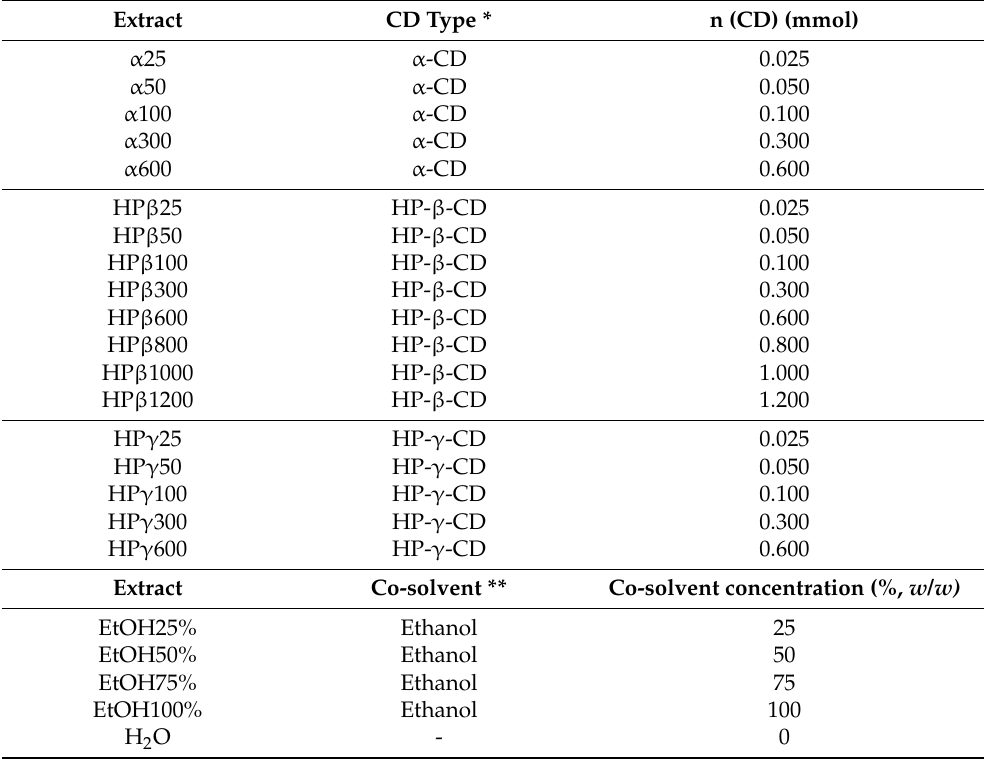
Table 1. Conditions for preliminary extraction procedure using either cyclodextrins (CDs) dissolved in water (10 g) or mixtures of ethanol and/or water (10 g) stirred at 25 ◦ C and 300 rpm for 24 h.